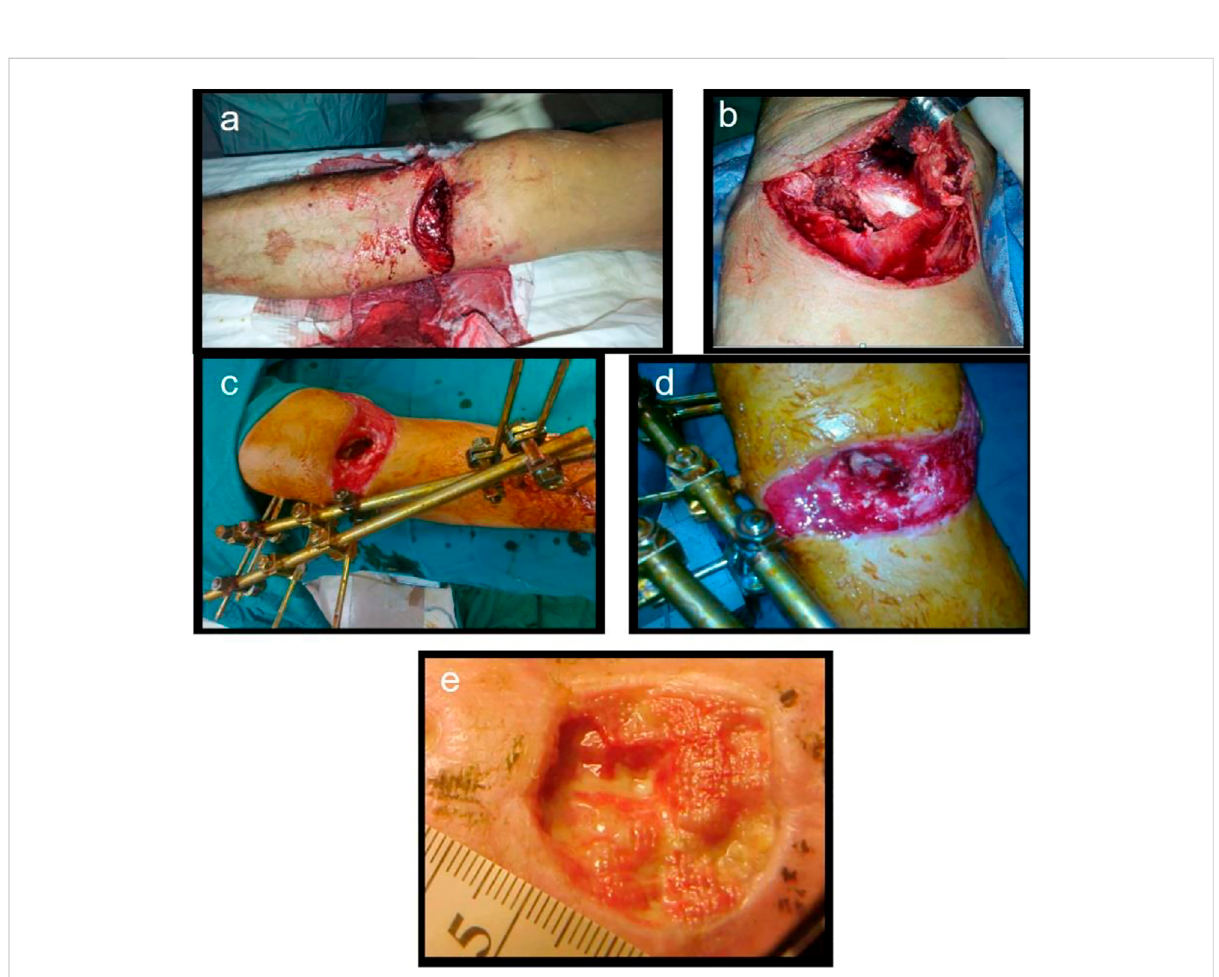
FIGURE 1 Openfractureoftheproximaltibialmetaphysis (A) ,massivesofttissueinjuries,periostealstripping (B) ,external fi xatorwithkneespanning,bone defect visible (C) , Collatamp G fi lling the bone defect (D) , remaining skin defect, secondary epitelisation (E) . Reproduced with permission from Lupescu et al. (2016). Copyright Trans Tech Publications